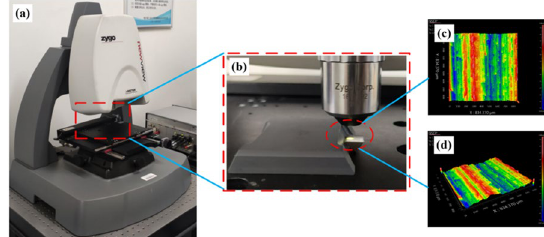
Figure 5 Schematic diagram of the machined surface topography